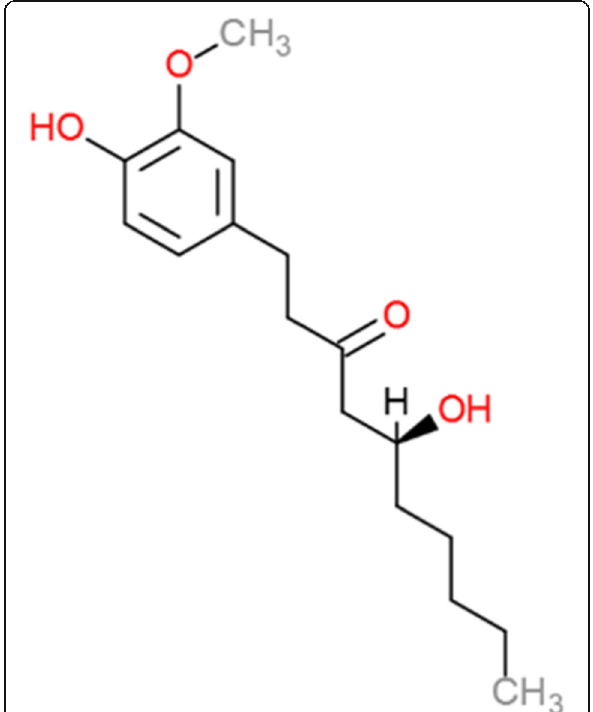
Fig. 2 The chemical structure of 6-gingerols, the main active constituent of ginger, Zingiber officinale . Modified after Qui et al. [19]. 6-gingerol is derived from the phenylalanine pathway and has potential to be anti- septic, to have anti-cancer properties and reducing nausea and